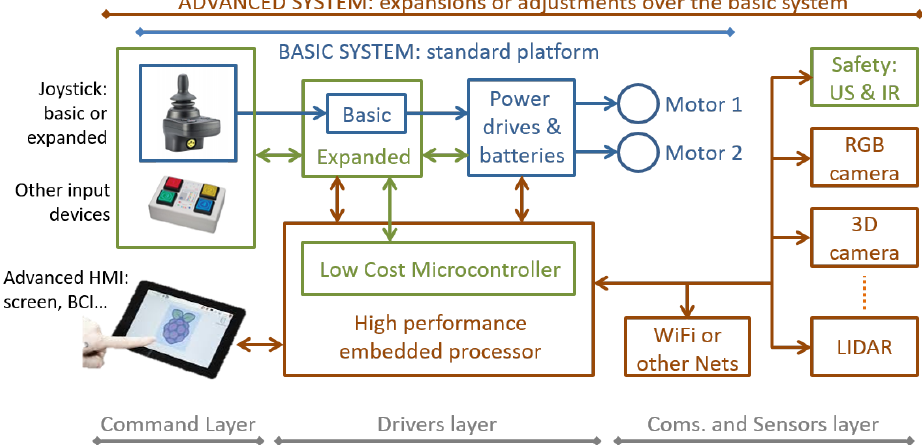
Figure 3. Block diagram of the intelligent wheelchairs (IWs) modular